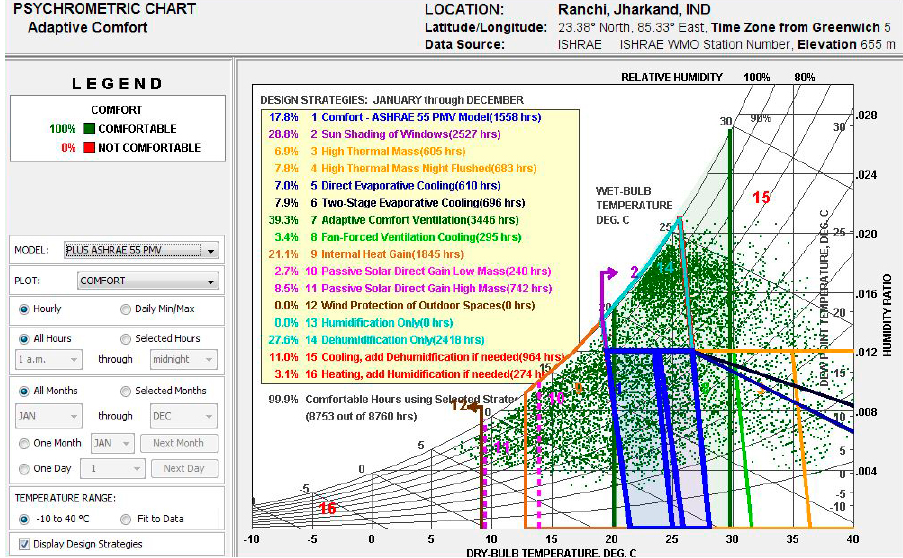
fig. 14. revised Building Bio-Climatic Comfort Chart (BBCC) for ranchi, jharkhand showing limits of thermal comforts as per adaptive Comfort Model and how building design strategies cause adjustments in comfort zone Source: generated in Climate Consultant Software by author after uploading detailed climate file for ranchi.